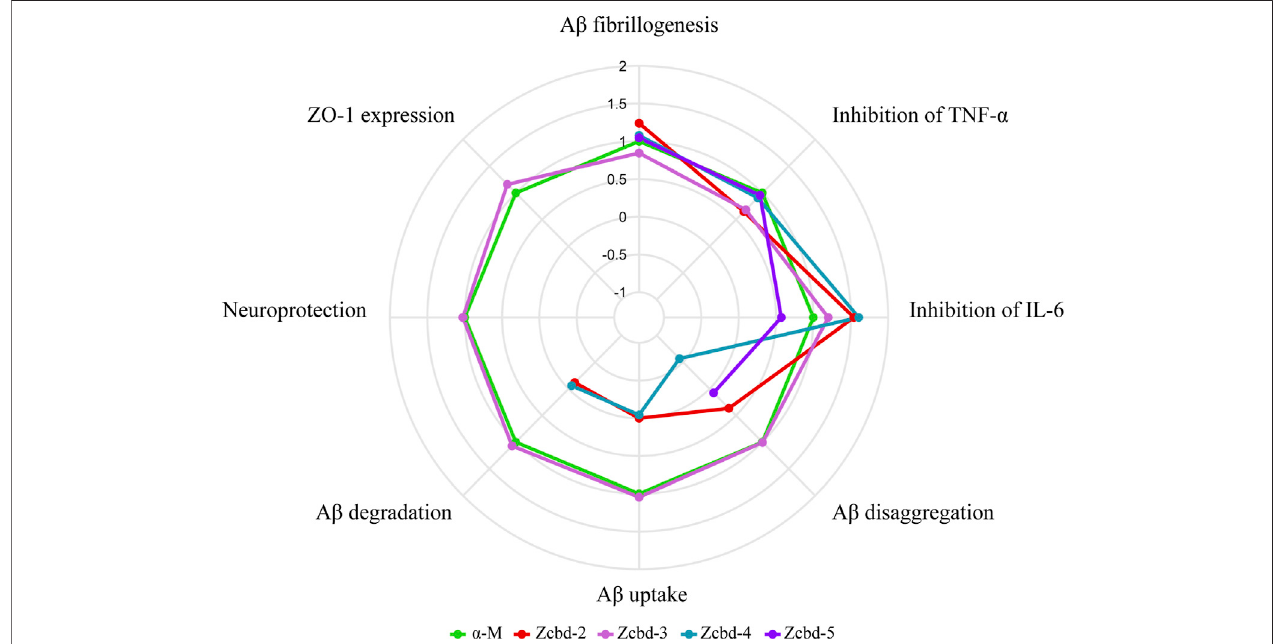
FIGURE 7 | Multifunctional anti-AD effects of α -M and its analogues. The radar plot of properties included eight aspects, which were A β fi brillogenesis, inhibition of TNF- α , inhibition of IL-6, A β disaggregation, A β uptake, A β degradation, neuroprotection and ZO-1 expression. The performance of the four analogues was compared with the control group (CTRL) and normalized to the effects of α -M. Polylines were used instead of the value “ 0 ” to represent analogues ’ performance, which was eliminated during the experimental process.